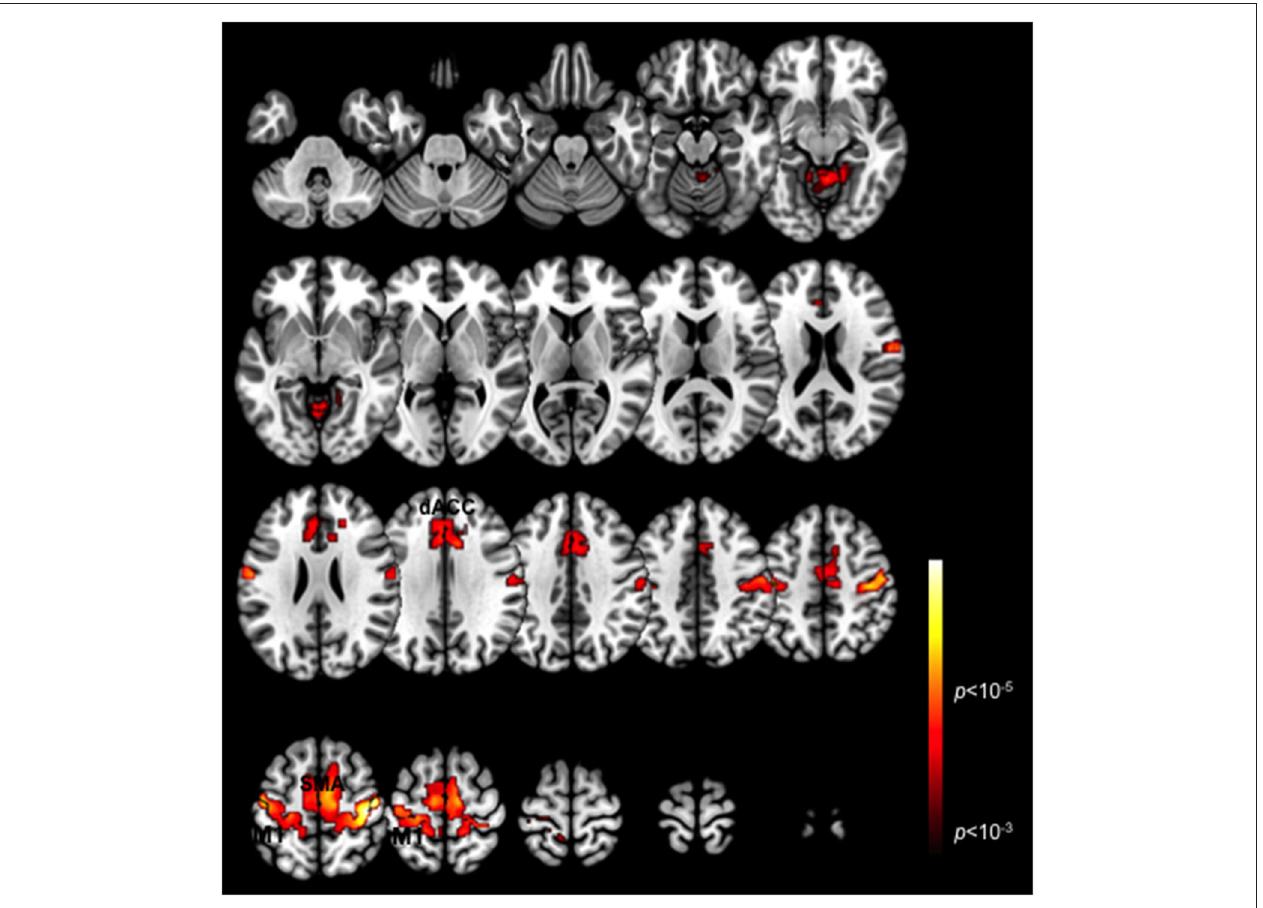
clusters ( p < 0.01, cluster level) are overlaid on a mosaic of axial views that reveal task-related activations in the dACC, SMA, M1 and the